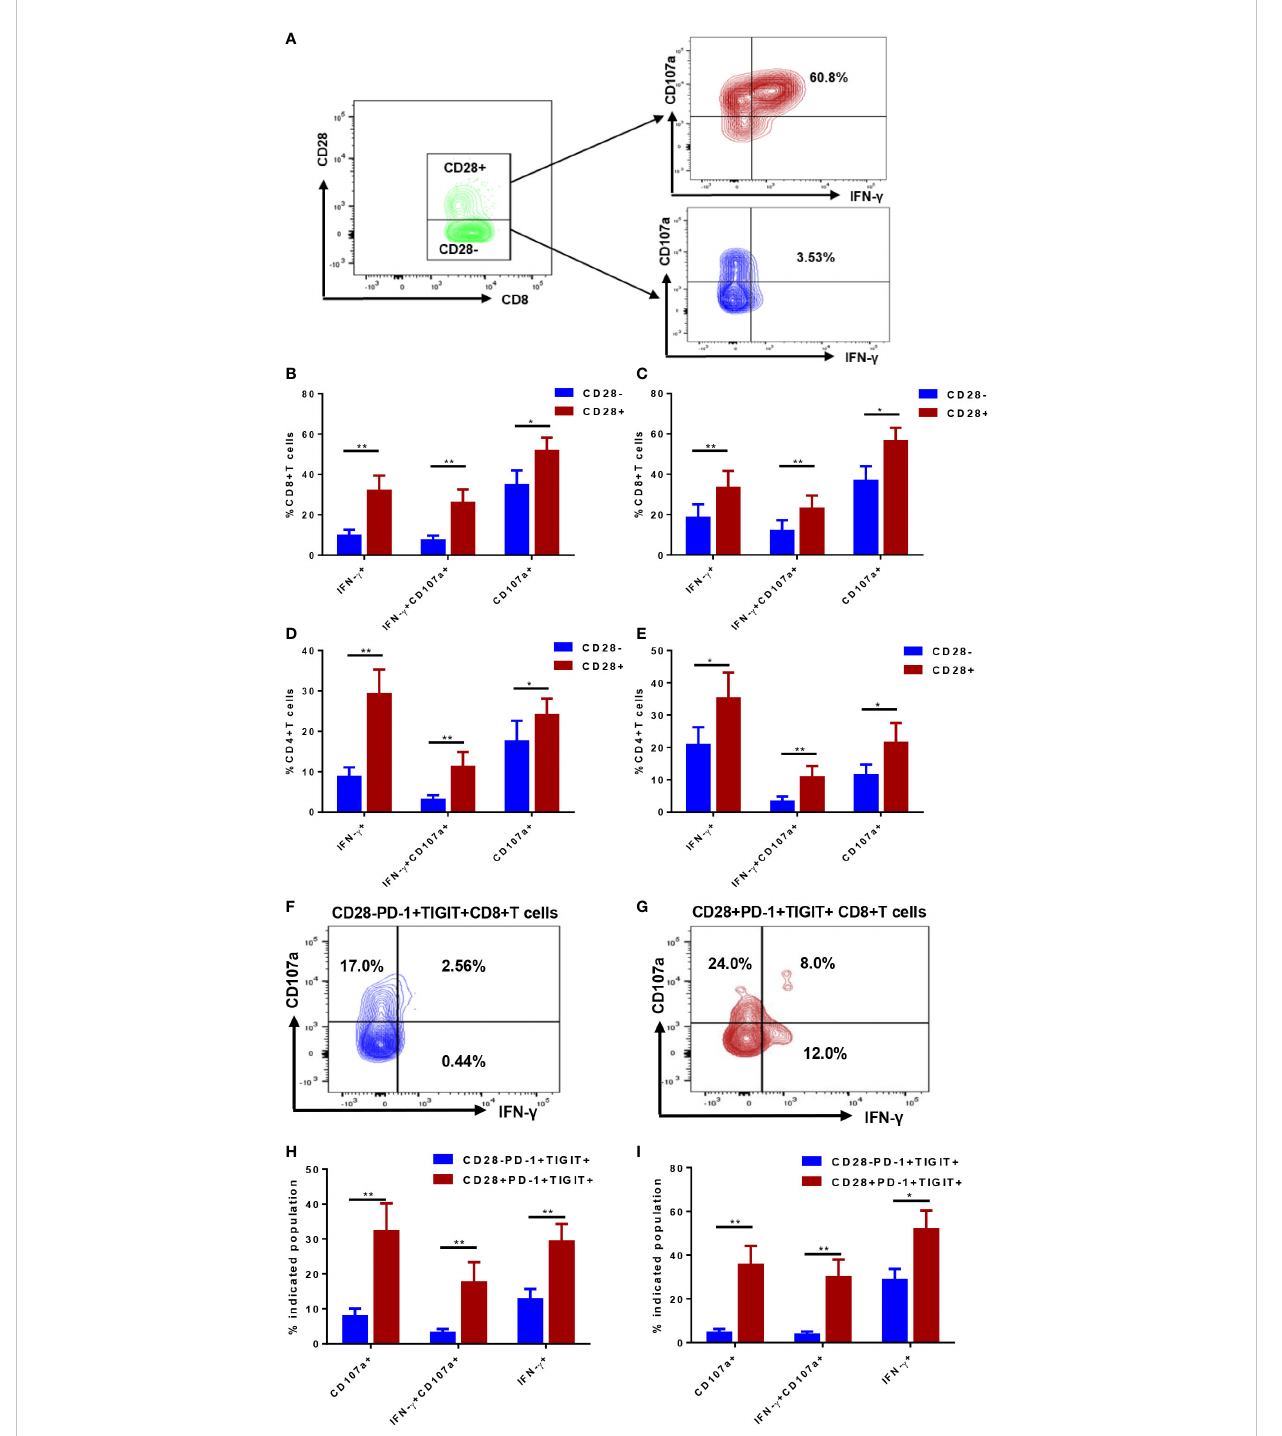
FIGURE 4 Function analysis of CD28 - subsets and the counterparts of T cells in in the bone marrow (BM) of de novo AML patients. Degranulation capacity and interferon-gamma (IFN- g ) were determined in CD28 - and CD28 + T-cell subsets (A) ; CD107a expression and IFN- g production were simultaneously evaluated in CD28 - and CD28 + subsets of CD4 + T cells (B) and CD8 + T cells (C) stimulated by anti-CD3/CD28 antibody ex vivo (n=17). Additionally, CD107a expression and IFN- g production were simultaneously evaluated in CD28 - and CD28 + subsets of CD4 + T cells (D) and CD8 + T cells (E) stimulated by PMA/ionomycin ex vivo (n=13). Further analyses were performed to evaluate CD28 - PD-1 + TIGIT + CD8 + (F) and its counterpart (G) of CD8 + T cells; CD107a expression and IFN- g production were evaluated in CD28 - PD-1 + TIGIT + and its counterpart of CD4 + T cells (H) and CD8 + T cells (I) stimulated by anti-CD3/CD28 antibody ex vivo (n=17). Paired Student ’ s t test or Wilcoxon matched-pairs signed rank test was used to analyze the data according to normal distribution of data. *, ** indicated p-values between 0.01 to 0.05, 0.001 to 0.01